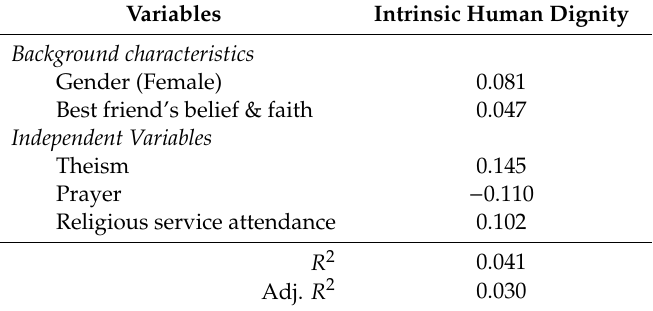
Table 9. Regression analysis for intrinsic human dignity with weights ( β ) for each variable and total explained variance ( R 2 and adjusted R 2